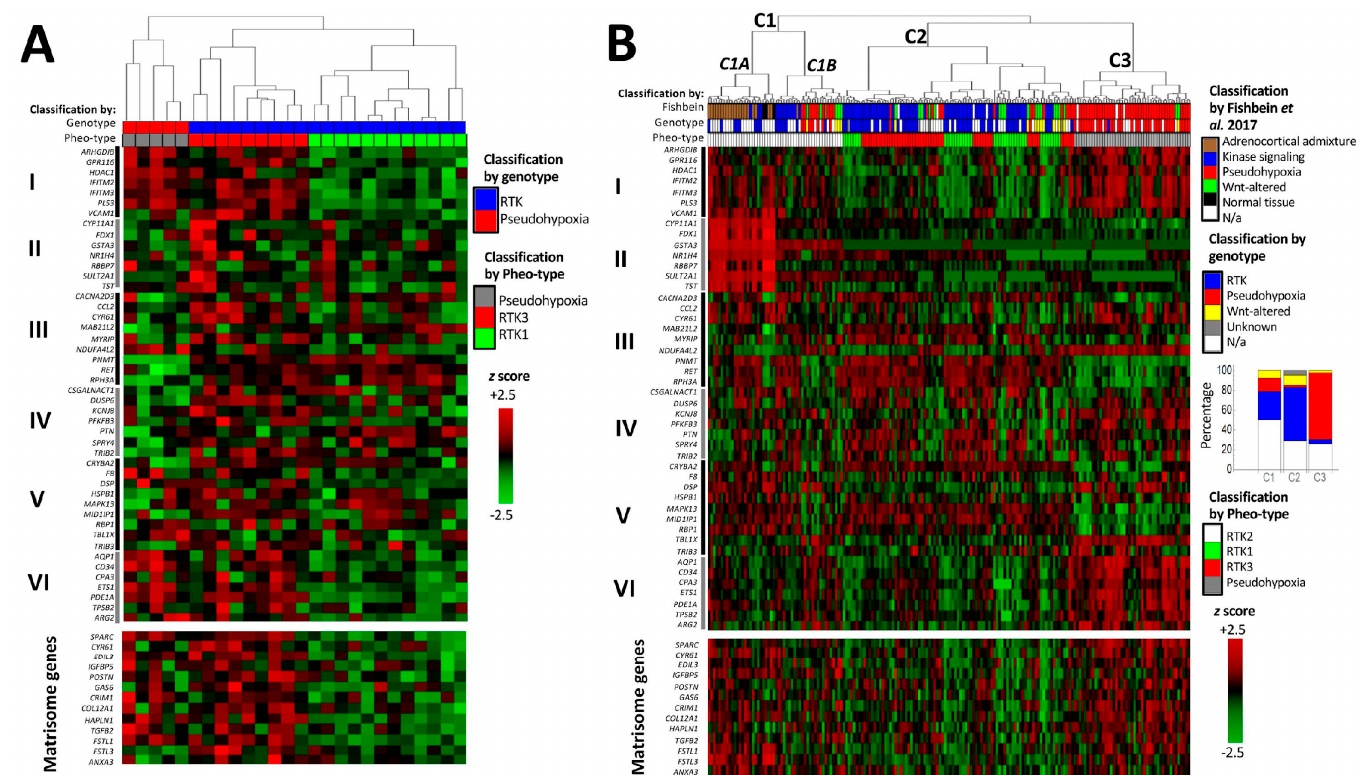
Figure 5. cDNA hybridization microarray data on Scandinavian PPGL with known genotype ( A ) [36] and RNA-sequencing data on The Cancer Genome Atlas cohort ( B ) [14]. The upper heatmap panel displays the expression profile of the Pheo-Type gene set, and the lower panel displays the expression of matrisome-related genes downregulated by NRAS in the hPheo1 cell line. Pheo-Type gene set subdivisions are as described by Flynn et al. [37] and denominated with Roman numerals I–VI (explained in the text). Genotypic subtype indicated as pseudohypoxic (red; VHL , SDHx , EPAS1 , IDH1 , or EGLN1 mutation), receptor tyrosine kinase (RTK)-driven (blue; NF1 , HRAS , RET , FGFR1 , TMEM127 , BRAF , NFGR or MAX mutation), WNT-altered (yellow; CSDE1 or MAML3 mutation), not applicable (N / a, white), i.e., unknown mutation or known mutation of uncertain mRNA subtype ( SETD2 , TP53 , ATRX ). Pheo-Type cluster classification indicated as pseudohypoxic (grey; C3), RTK1 (Green; C2), RTK2 (white; C1A / B) or RTK3 (red; C3). Dendrograms are longitudinally compressed for visualising purposes.